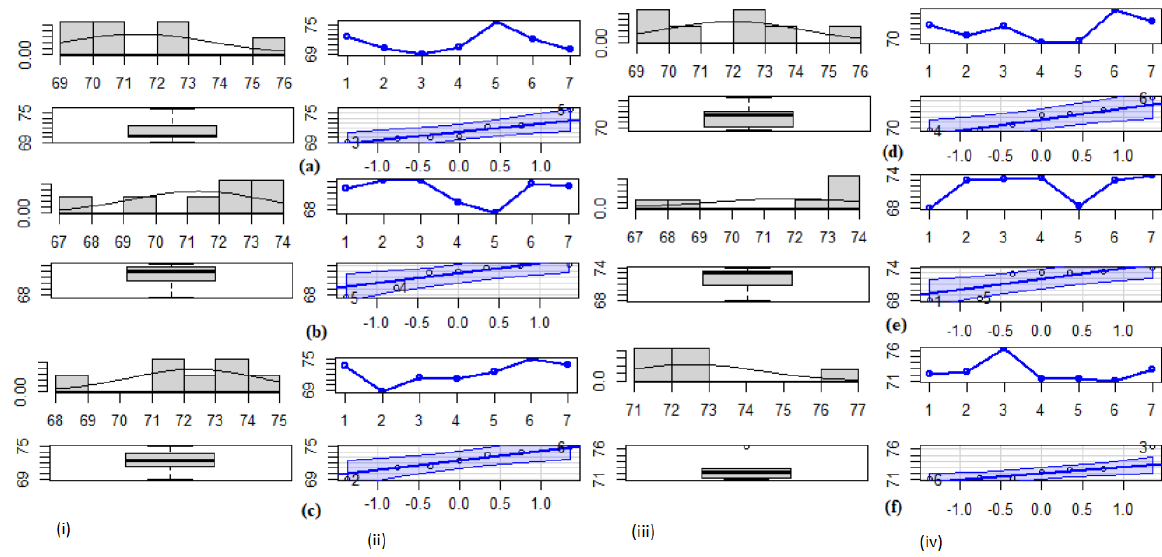
Figure 2. IoTDixon normal distribution evaluation (i) histogram with density curve (top-left), (ii) plot of data points, (iii) box plot, and (iv) QQ plot. ( a ) x1 dataset, ( b ) x2 dataset, ( c ) x3 dataset, ( d ) x4 dataset, ( e ) x5 dataset, and ( f ) x6 dataset.